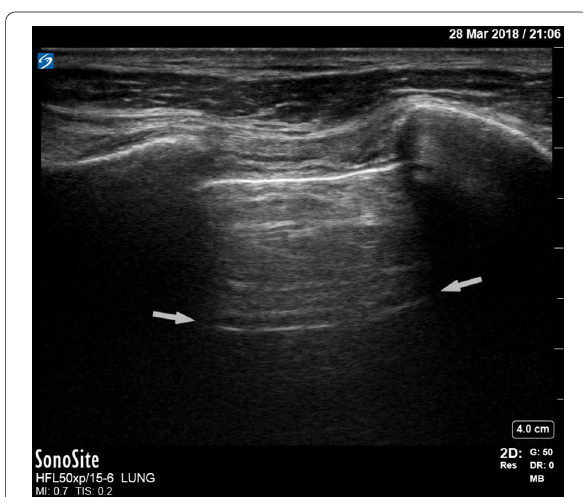
Fig. 4 Pneumothorax A‑line. A‑lines are reflections of the pleural + line caused by gas below the parietal pleura. An A‑line is indicated by the arrows. The A is for “air” either within or outside of the lung. In case of a pneumothorax, there are no B‑lines (Fig. 2) that may obscure the A‑lines making them stand out more